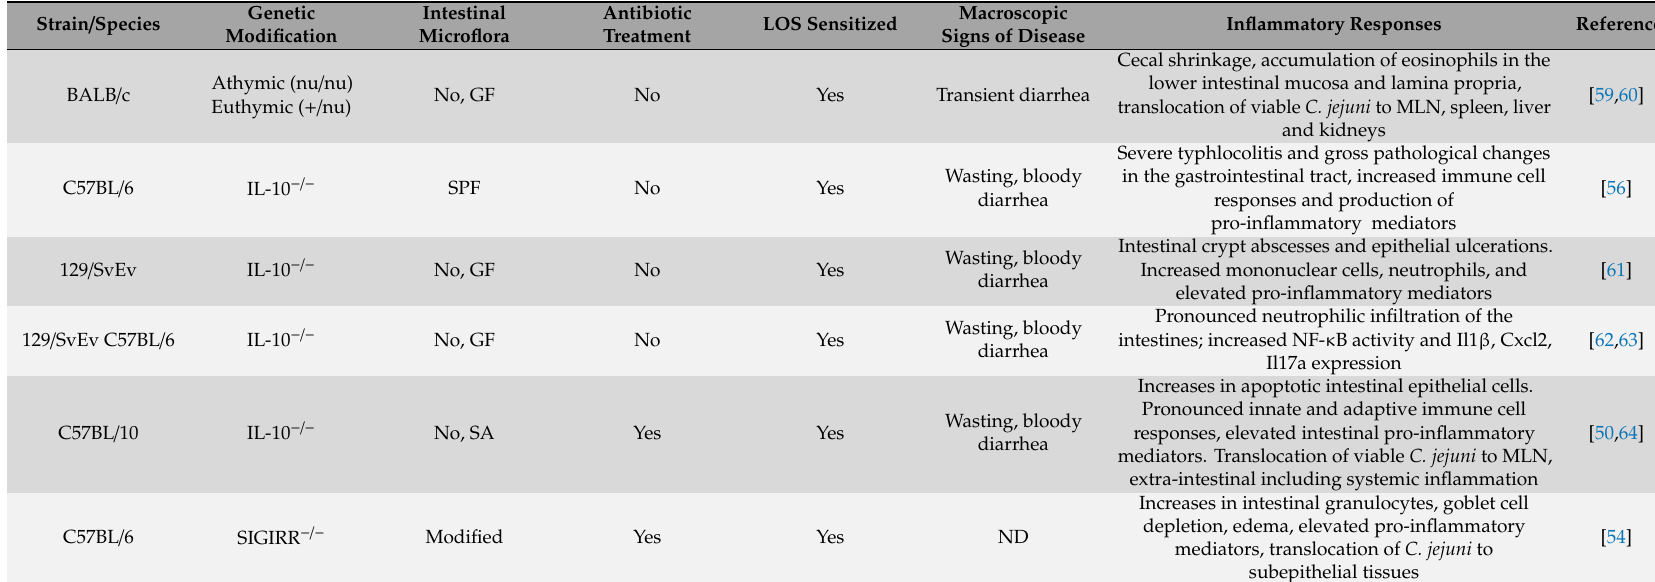
Table 2. Murine models of campylobacteriosis applying genetically modified